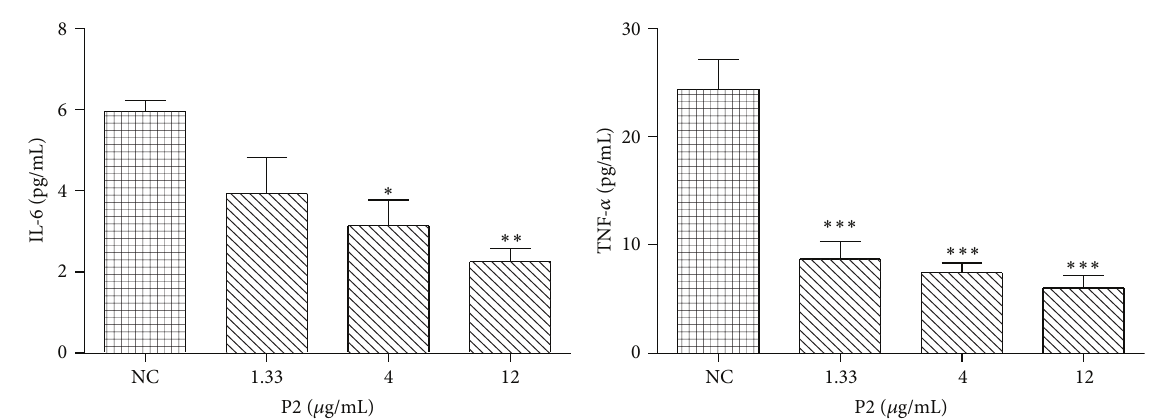
Figure 2: Effect of P2 on proinflammatory cytokine secretion in HeLa cells. Levels of IL-6 and TNF- 𝛼 secreted by HeLa cells after 48 h incubation were assayed by human IL-6 and TNF- 𝛼 ELISA kits. ∗ 𝑃 < 0.05 and ∗∗ 𝑃 < 0.01 compared with normal control (NC). The results are representative of three independent experiments and expressed as mean ± SD. Differences were defined as significant at 𝑃 < 0.05 .